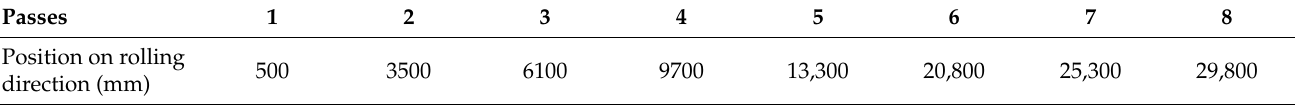
Table 8. Positions of centres of each roll along the rolling direction with reference to the initial slice position.